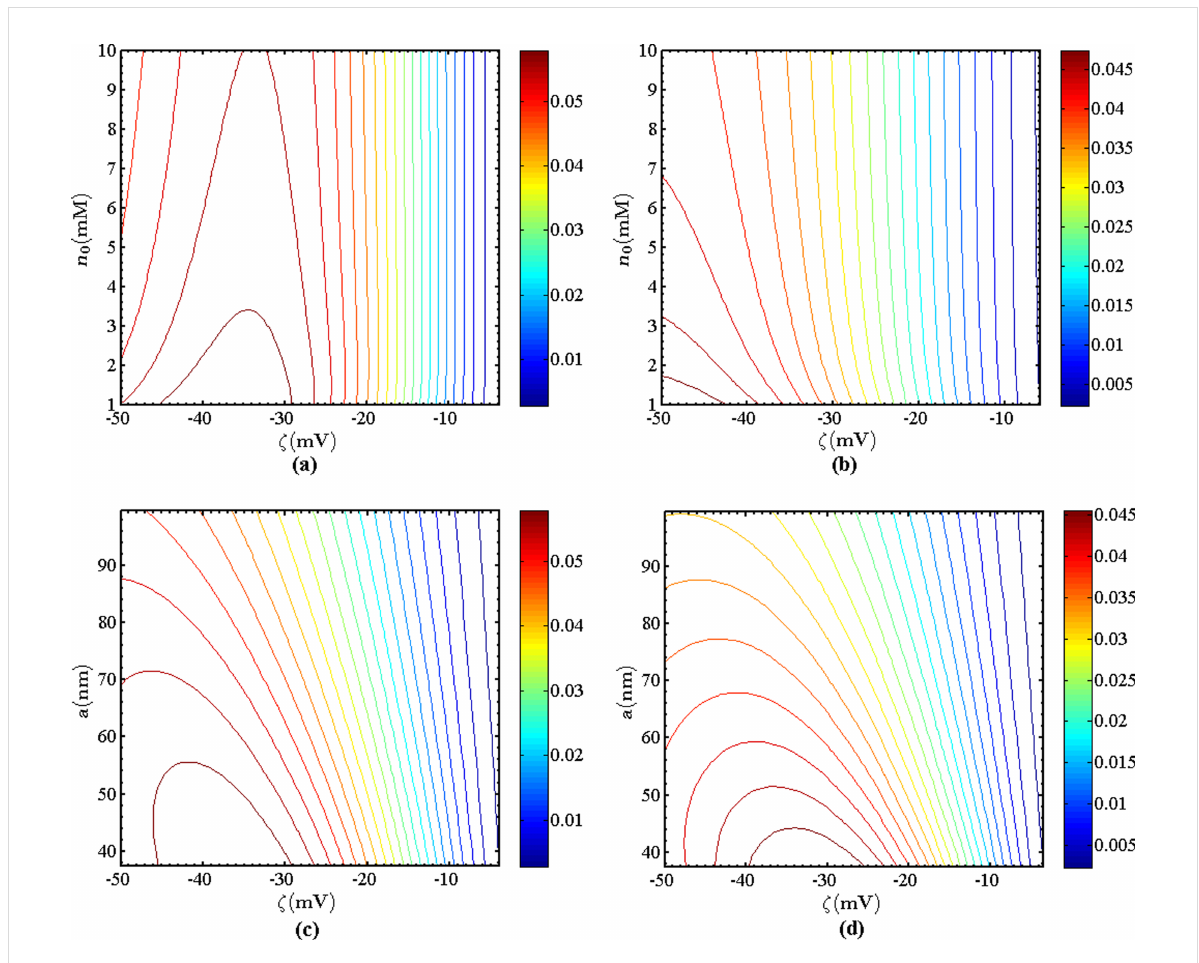
Figure 3: (a, b) Contours of the electrokinetic energy conversion efficiency ( ω = 10 − 1 MHz, b 0 = 40 nm) for different radii: (a) a = 37.5 nm and (b) a = 100 nm; (c, d) contours of the electrokinetic energy conversion efficiency ( ω = 10 − 1 MHz, b 0 = 40 nm) for different ionic concentrations: (c) n 0 = 1 mM and (d) n 0 = 100